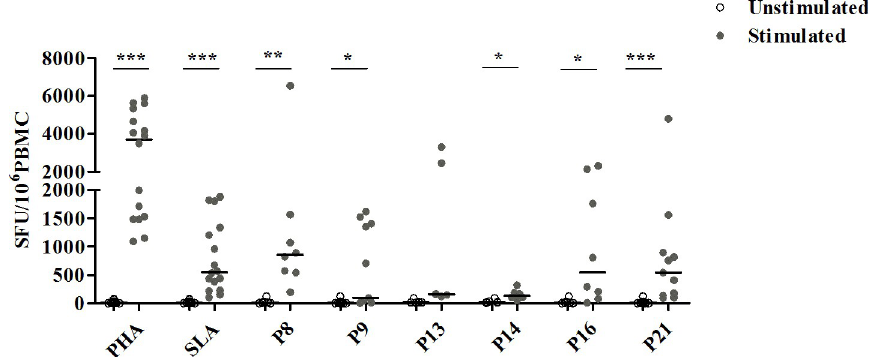
Fig 7. Enumeration of IFN- γ -secreting T cells in response to selected multi-epitope peptide pools. PBMC from cured CL subjects (N = 11), previously stimulated with selected peptide pools (1 μ M/peptide) for 10 days, were re- stimulated for 24 h with the same peptide pools at the same concentration. PHA and SLA were used as positive controls (10 μ g/ml). Results are expressed as spot forming units (SFU) per million PBMCs. Horizontal bars represent median values. Statistical significance was assigned to a value of p < 0,05 ( � p < 0.05, �� p < 0.01, ��� p < 0.001).